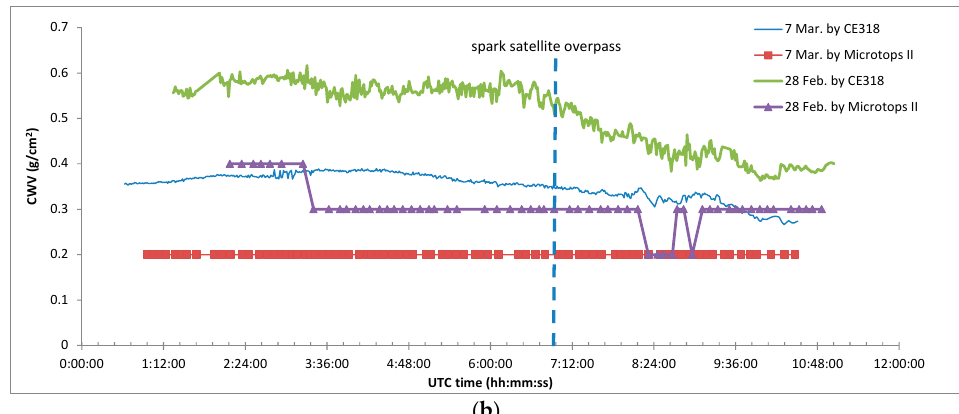
Figure 9. 550 nm AOD ( a ) and CWV ( b ) retrieved from CE318 measurements and Microtops II measurements on 7 March and 28 February 2017, respectively.